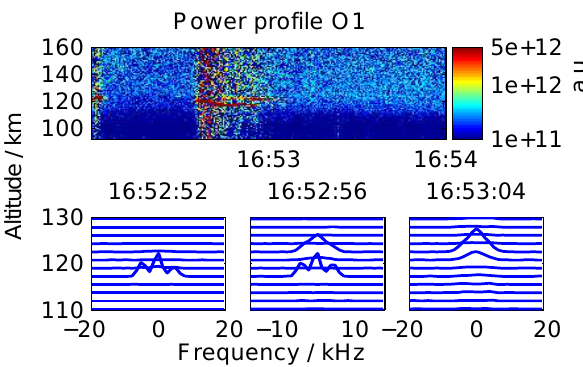
Fig. 2. The top panel shows the radar power profile observed dur- ing O-mode heating cycle O1 (16:52–16:54UT) with enhancements in backscattered power from two distinguished altitude layers. At times of enhanced backscatter self-clutter caused by the radar pro- gram can be seen at altitudes up to 180km. In the bottom panel ion-line spectra are shown measured at 16:52:52, 16:52:56 and 16:53:04UT with 4s integration. The spectra are normalized to an arbitrary value and the baseline of each spectrum corresponds to altitude.